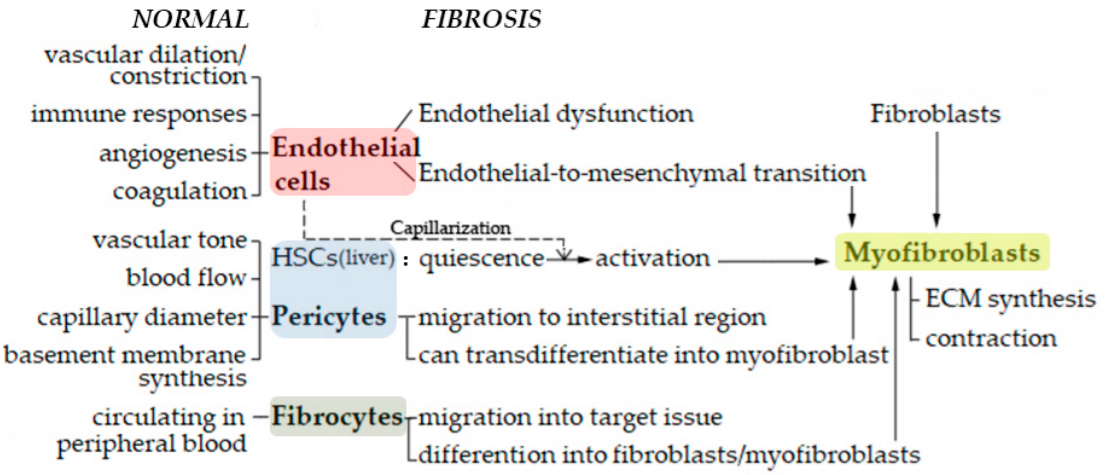
Figure 1. A brief outline of the participation of endothelial cells, pericytes, hepatic stellate cells (HSCs), fibrocytes and myofibroblasts in soft tissue fibrosis, in comparison to their normal roles.